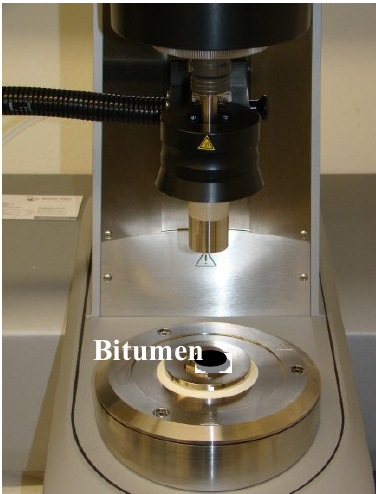
Figure 4. The dynamic shear rheometer (DSR) instrument and the applied sinusoidal